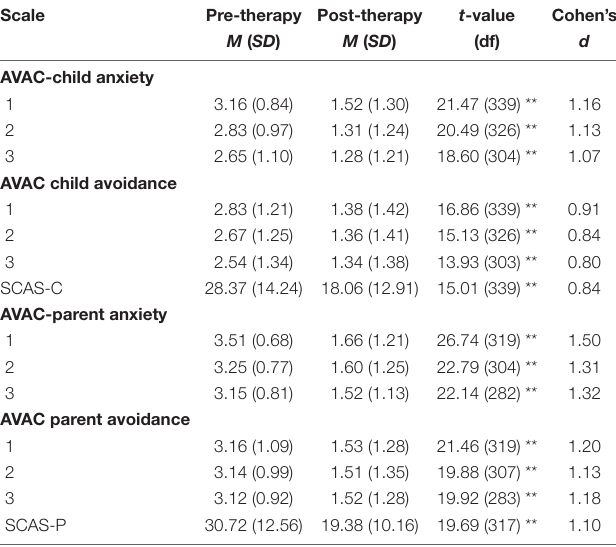
TABLE 4 | Comparison of Mean AVAC Anxiety, Avoidance, SCAS-C and SCAS-P Scores pre- and post-treatment (sensitivity to